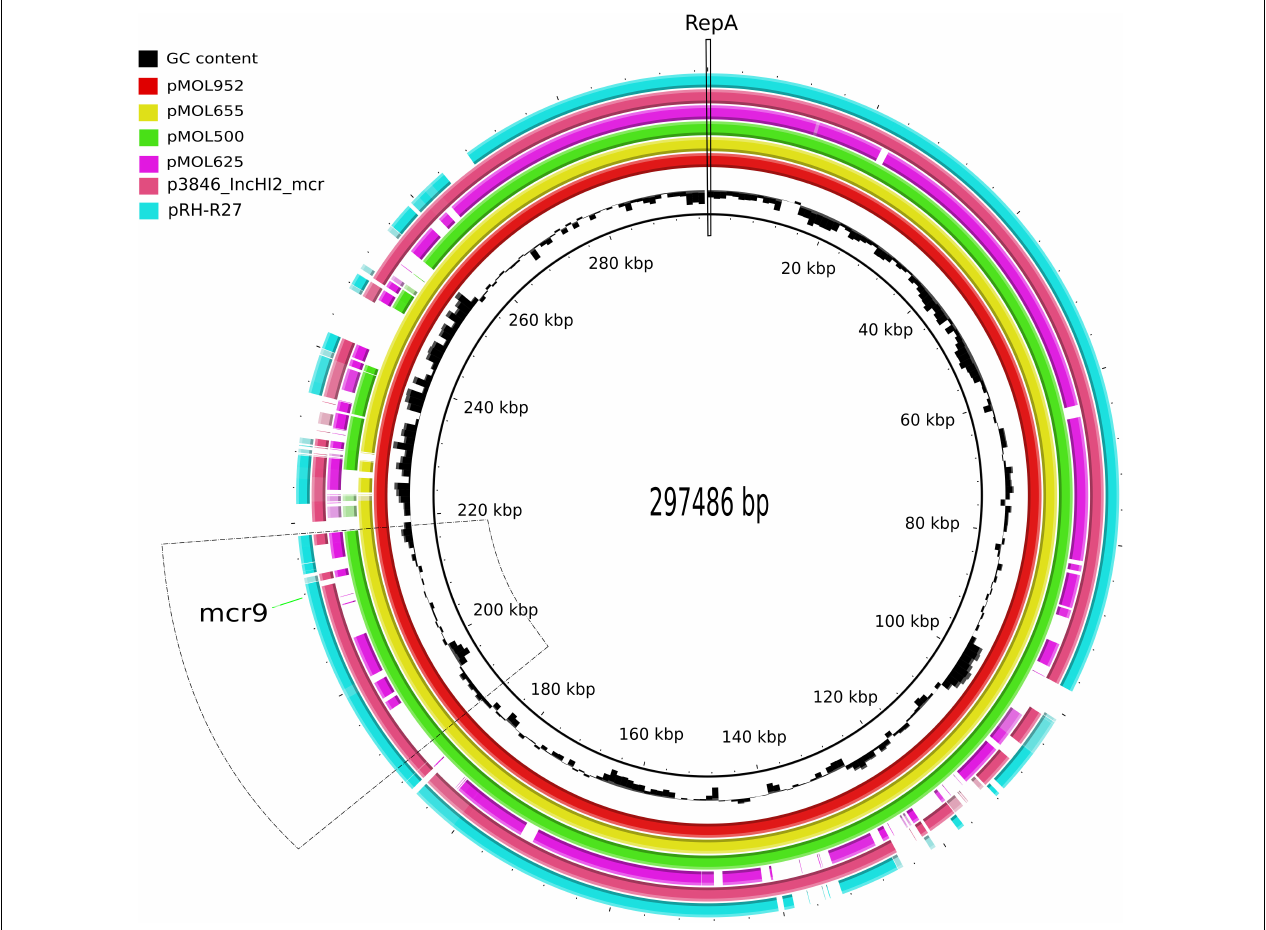
FIGURE 3 | Graphical comparison of the complete sequence of pMOL-952 (red; ERZ2110542), pMOL-665 (yellow; ERZ2110531), pMOL-500 (green; ERZ2110487), pMOL625 (fuchsia; ERZ2110516), p3846_IncHI2 (old pink; CP052871), and pRH-R27 (blue marine; LN555650.1). The repA gene is indicated with a continuous line. The region including mcr-9 is indicated with a dotted